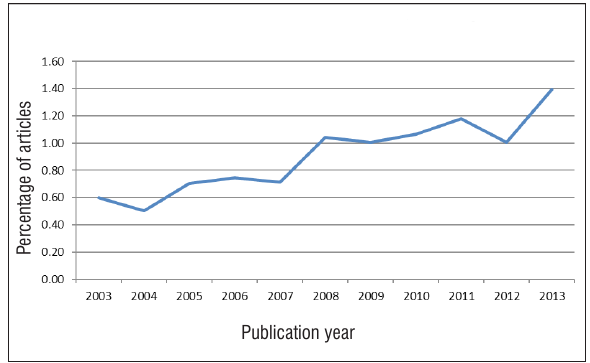
Figure 2: Percentage of energy-related articles relative to the total number of articles from South Africa in the period 2003–2013.